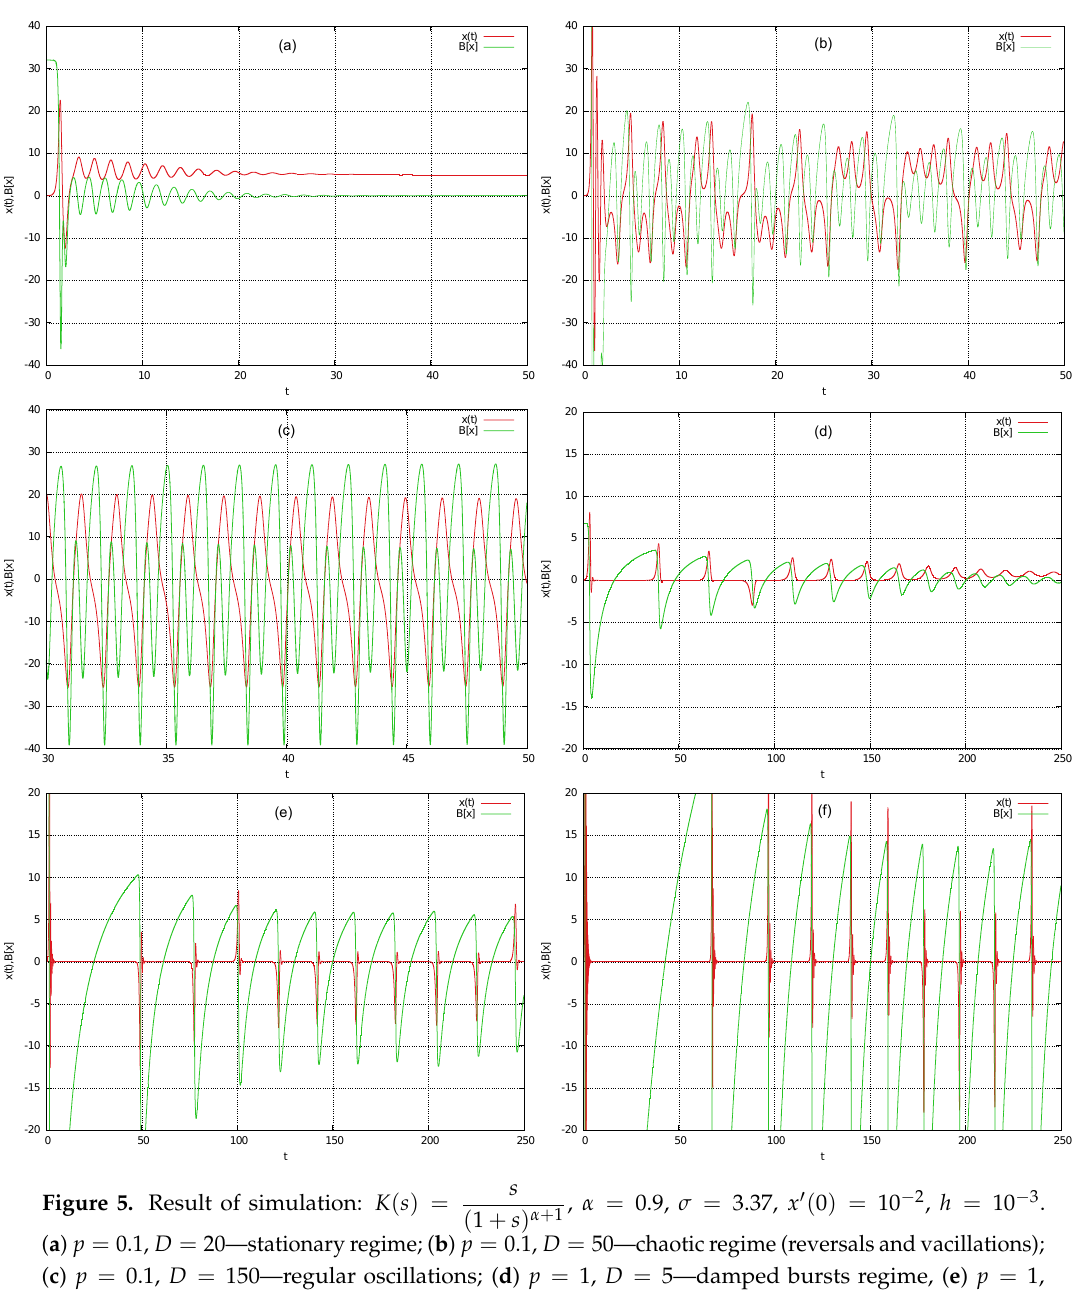
s , α = 0.9, σ = 3.37, x (cid:48) ( 0 ) = 10 − 2 , h = 10 − 3 ( 1 + s ) α + 1